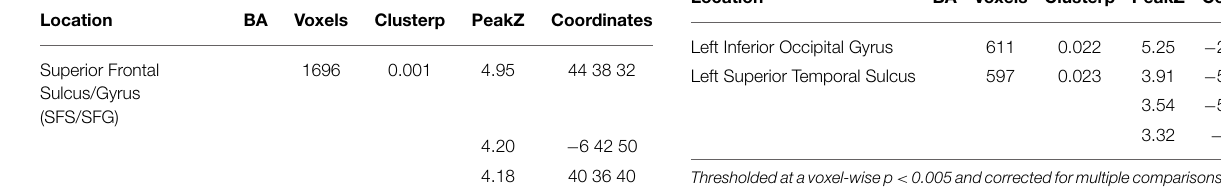
TABLE 3 | Regions activated by a 2Type(CP, NP) × 2Distance(O1, O2) interaction where (CPO2-CPO1) > (NPO2-NPO1). Location BA Voxels Clusterp PeakZ Coordinates